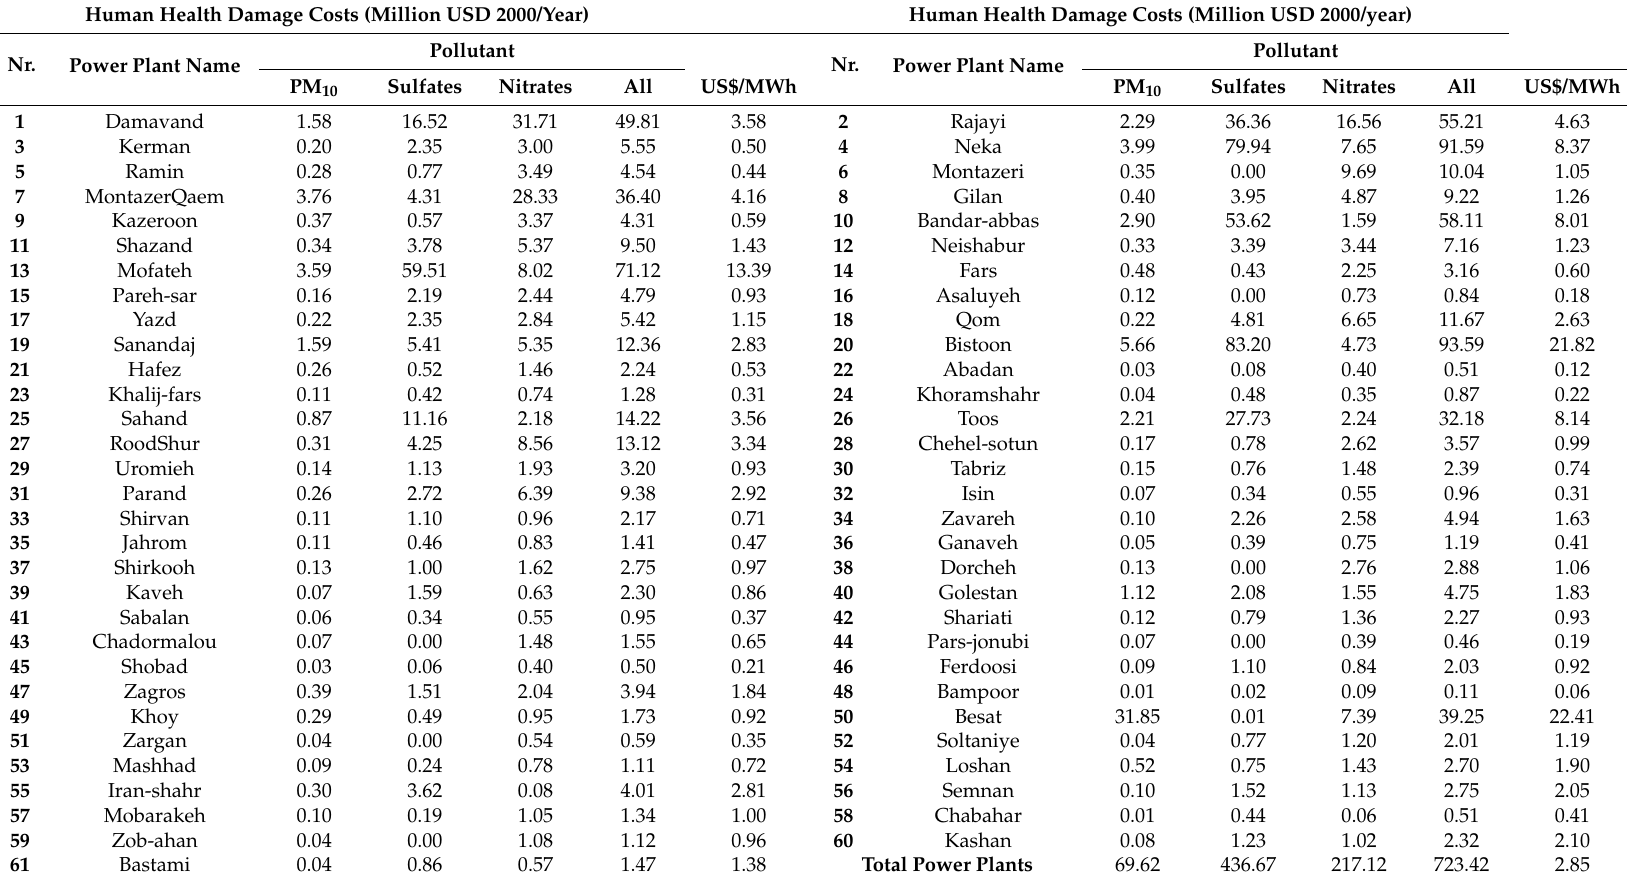
Table A5. Human health damage costs from the 61 power plants of Iran by type of pollutants and damage costs per generated electricity. Human Health Damage Costs (Million USD